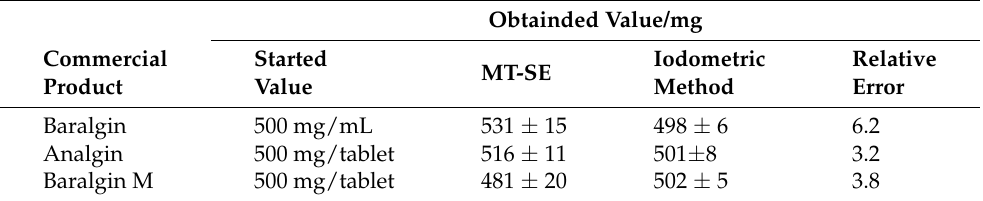
Table 4. Determination of dipyrone in pharmaceutical preparations using the proposed